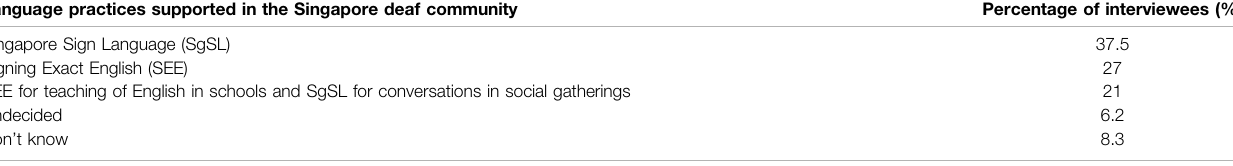
TABLE 1 | Language practices Supported in the Singapore Deaf